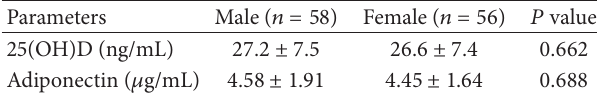
Table 1: Adiponectin and 25(OH)D levels according to gender.